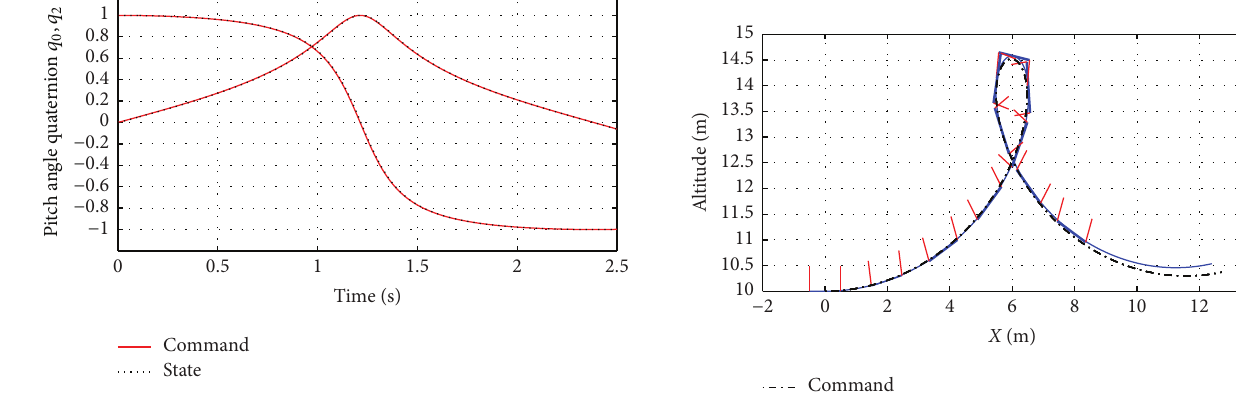
Figure 15: Command and state quaternion for a constant thrust loop.